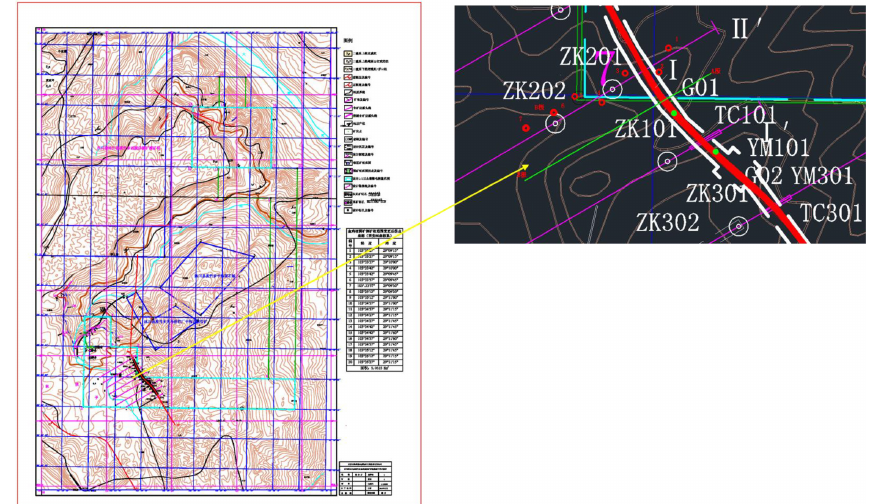
Figure 23. The mining area